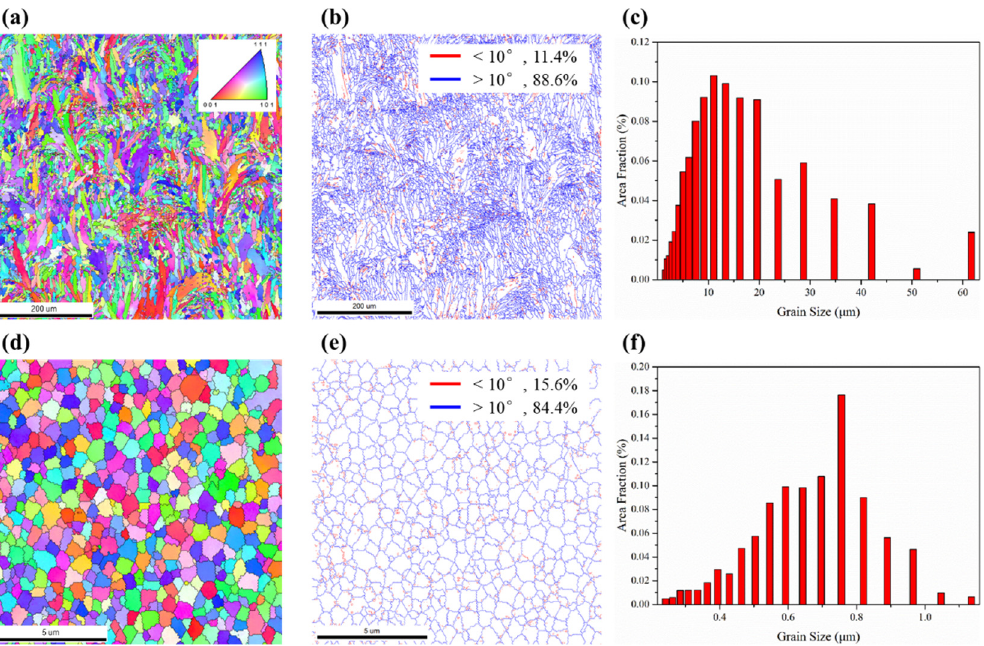
Figure 7. EBSD IPF maps, GBD maps and the average grain size and distribution maps of SLM- fabricated samples: ( a – c ) 316L stainless steel and ( d – f ) 2 wt.% HEA-reinforced composite.